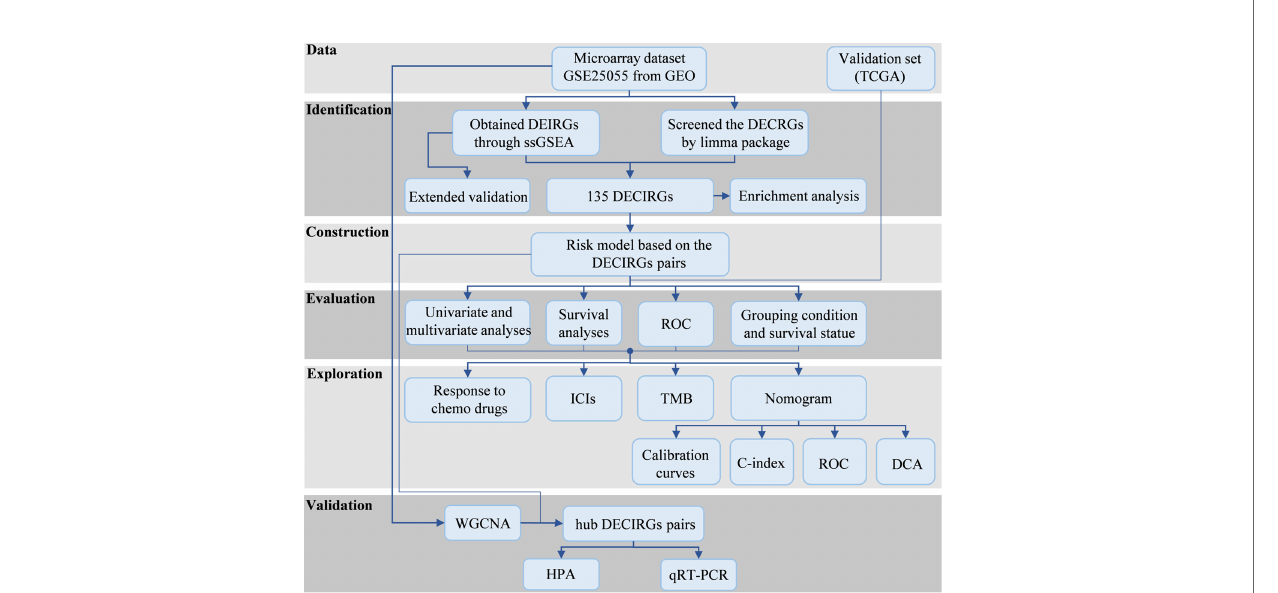
FIGURE 1 | The study processes. GEO, Gene Expression Omnibus; TCGA, The Cancer Genome Atlas; DEIRGs, differentially expressed immune-relevant genes; DECRGs, differentially expressed chemosensitivity-related genes; ssGSEA, single sample gene set enrichment analysis; DECIRGs, differentially expressed chemosensitivity-related and immune-related genes; ROC, receiver operating characteristic curves; ICs, immune checkpoints; TMB, tumor mutation burden; C-index, concordance index; DCA, decision curve analysis; WGCNA, Weighted Gene Co-Expression Network Analysis; HPA, Human Protein Atlas; qRT-PCR, quantitative reverse